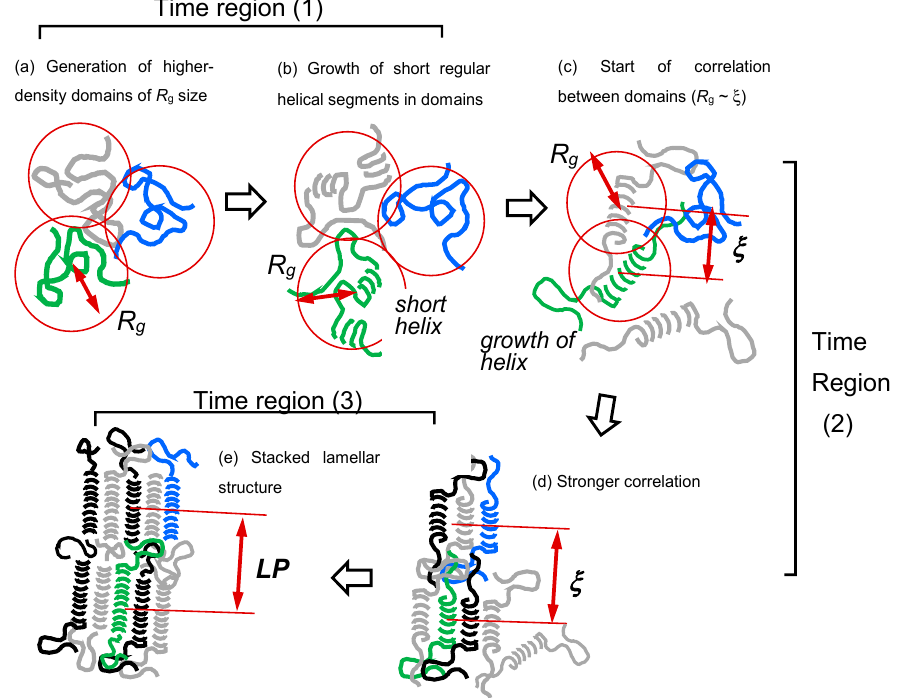
Figure 5. Illustration of a structural evolution process in the isothermal melt-crystallization of it -PP. ( a ) Higher-density domains of R g size are generated in the melt, ( b ) the short regular helices are generated in the domains, ( c ) and these domains start to correlate with each other. The correlation length may be defined in the various directions, among which the shortest correlation length ( ξ min ) can be detected in the normal SAXS measurement. The SAXS components corresponding to the longer correlation are hidden by the beam stopper. ( c , d ) The ξ min is converged finally with the averaged LP among the neighboring lamellae [36].